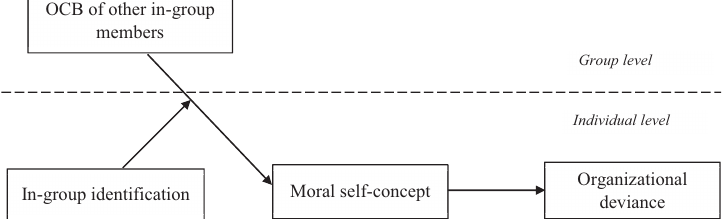
Figure 1. Theoretical